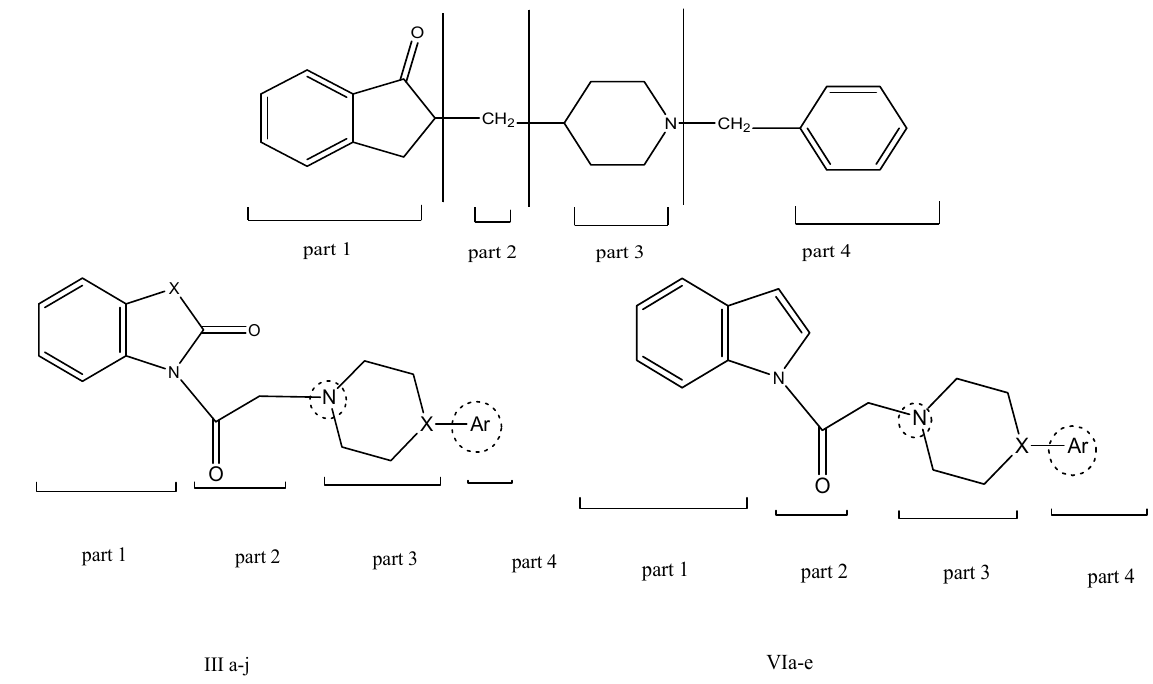
Figure 2. Resemblances between donepezil and synthesized derivatives, showing the four main parts important for biological activity.